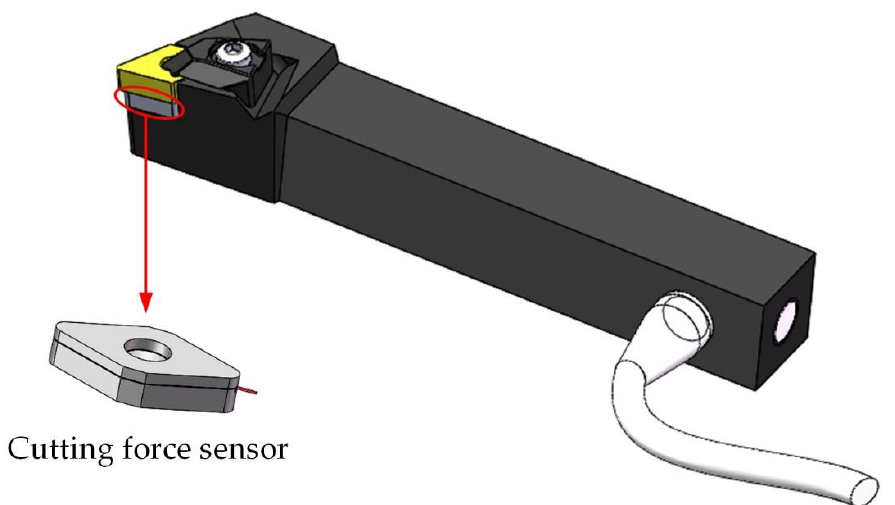
Figure 1. The overall structure of the cutting force measurement.